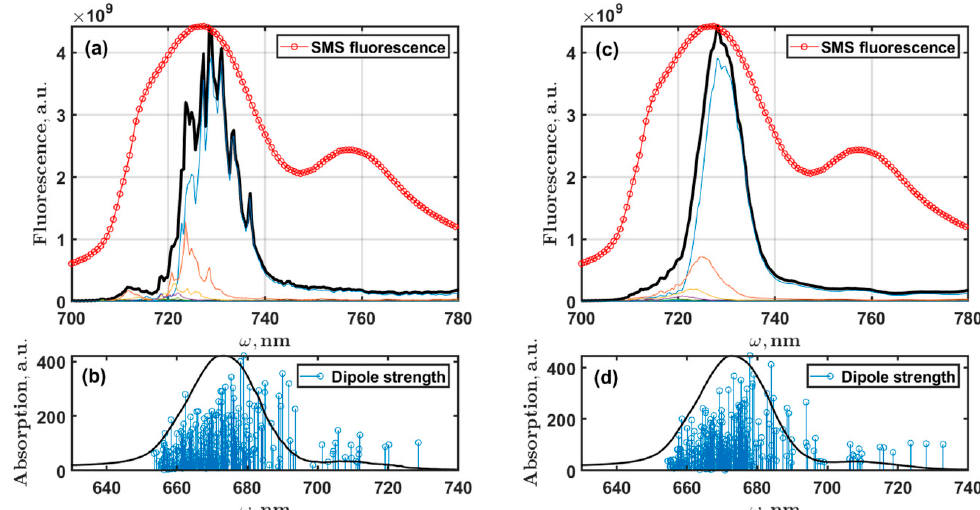
Figure 6. PSI trimer exciton fluorescence spectra calculated for 50 ( a ) and 1500 ( c ) realization of the Monte Carlo method are presented (black). The averaged SMS fluorescence experimental spectrum (red) is shown for comparison. The thin colored lines are the intensities of the exciton states. In addition to fluorescence spectra, the ϵ (cid:2961) − λ (cid:2961)(cid:2961)(cid:2961)(cid:2961) vales (stick spectrum) for a particular realization of the inhomogeneous broadening are marked in blue ( b , d lower plots) together with the absorption lineshape on the background. The length of the sticks is proportional to the dipole strength of the exciton states.